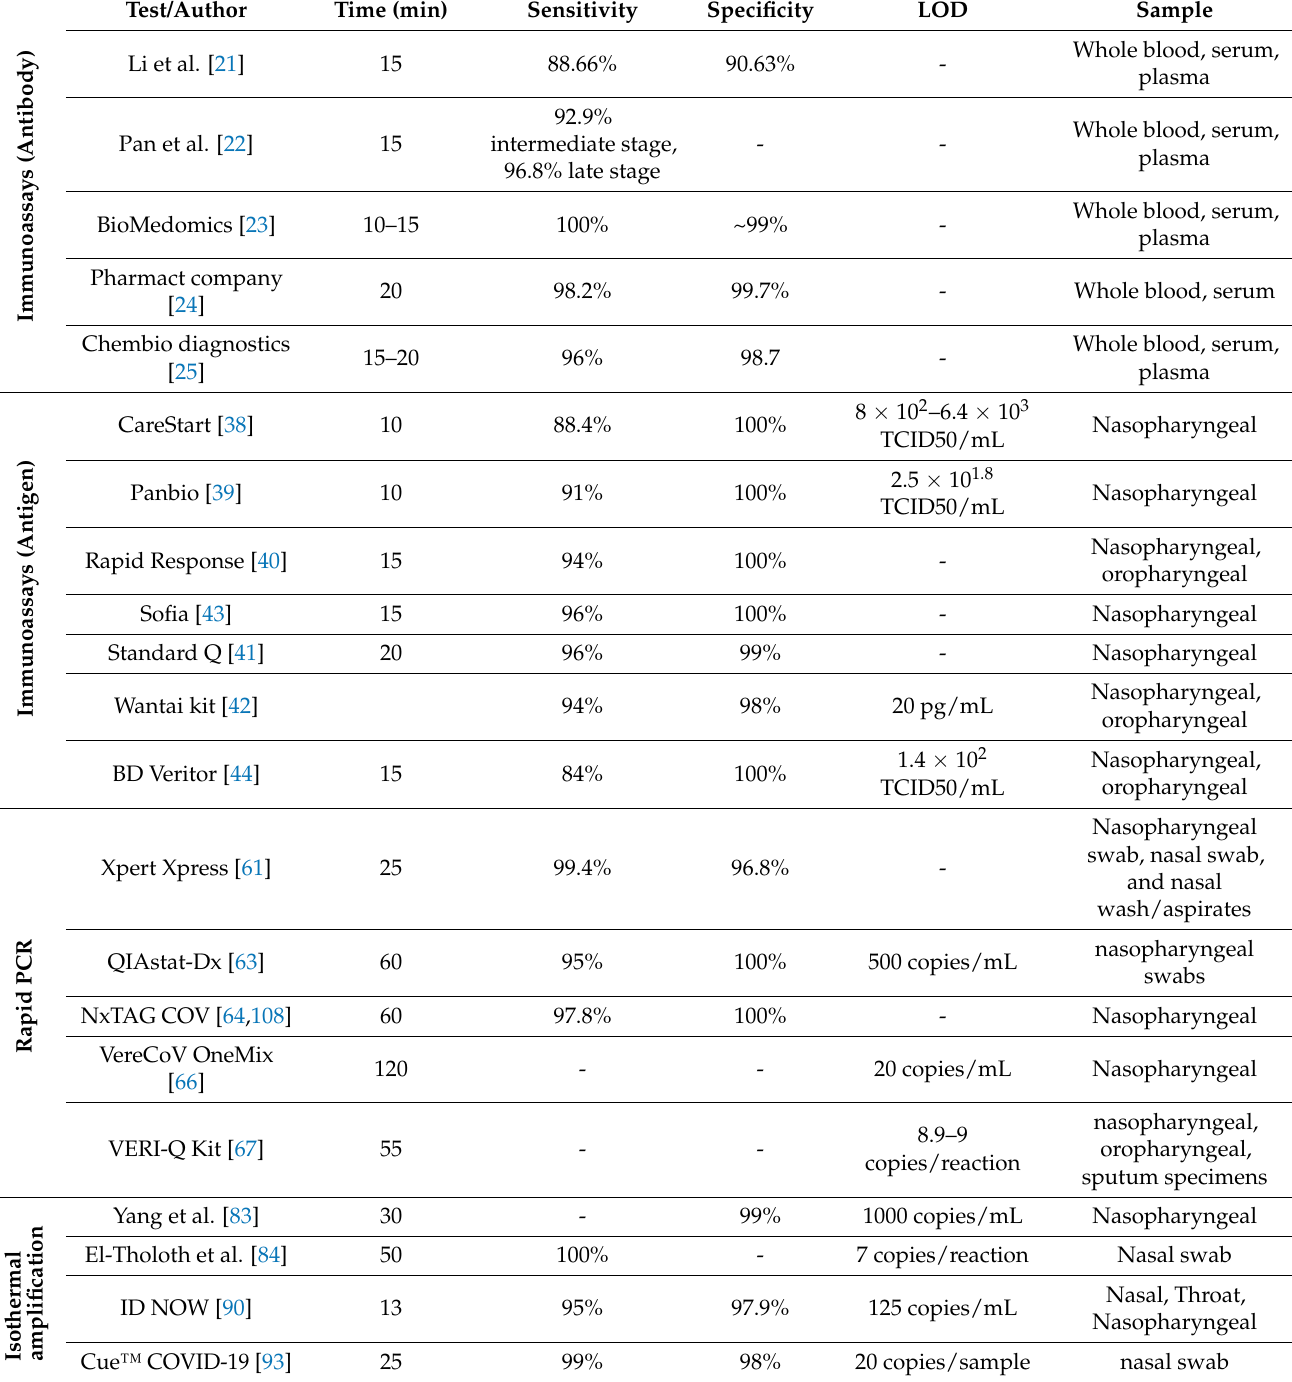
Table 1. Comparison of selected assays for COVID-19 detection based on the execution time, sensitivity, specificity, LOD, and analyzed